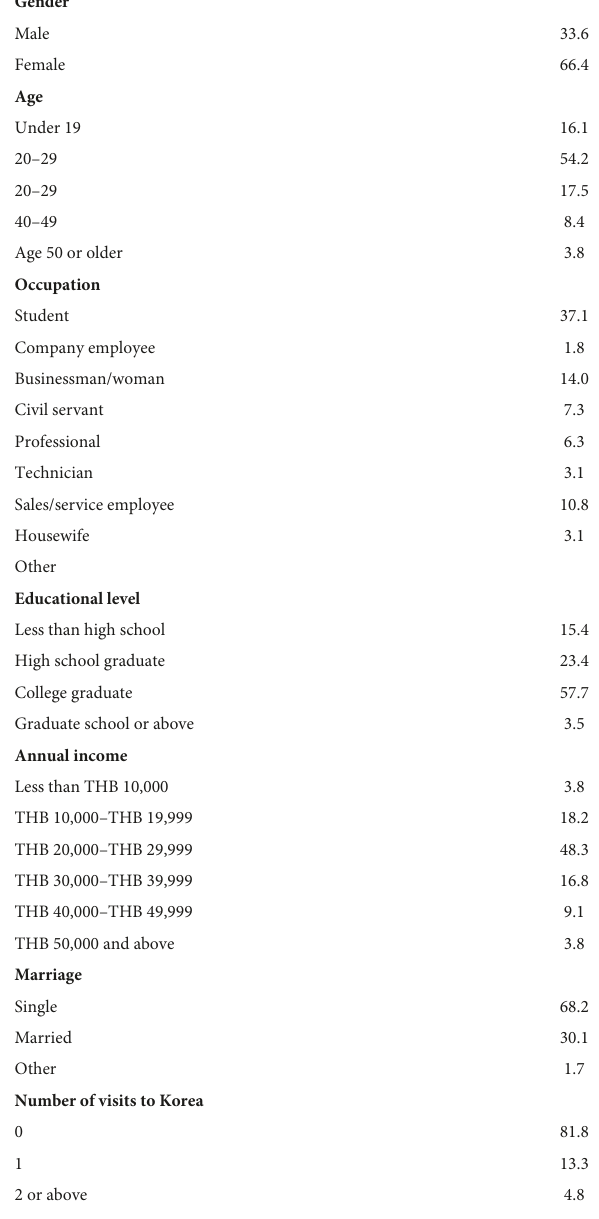
TABLE 1 Profile of respondents ( N =